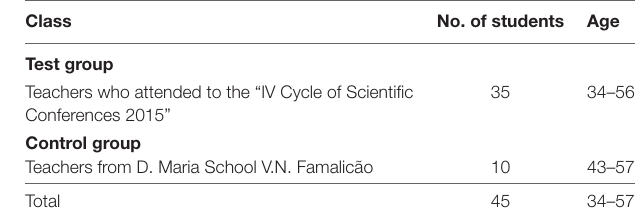
tAbLe 1 | Characterization of the test and control